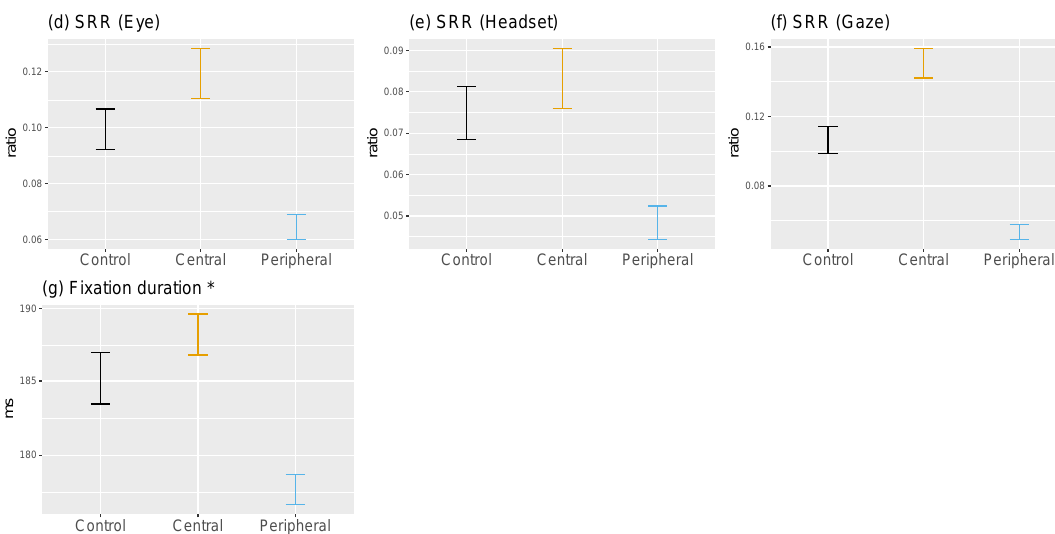
Figure 3. Visuo-motor variables are presented in this figure as a function of mask condition (control in black, central in orange and peripheral in blue) showing means and 95%CI. An asterisk to the right of a variable’s name indicates that it was log-transformed in linear mixed models and is presented on a log-scale here. SRR stands for saccadic reversal rate and measures the ratio of backward saccades produced precisely in the 170–190 deg.